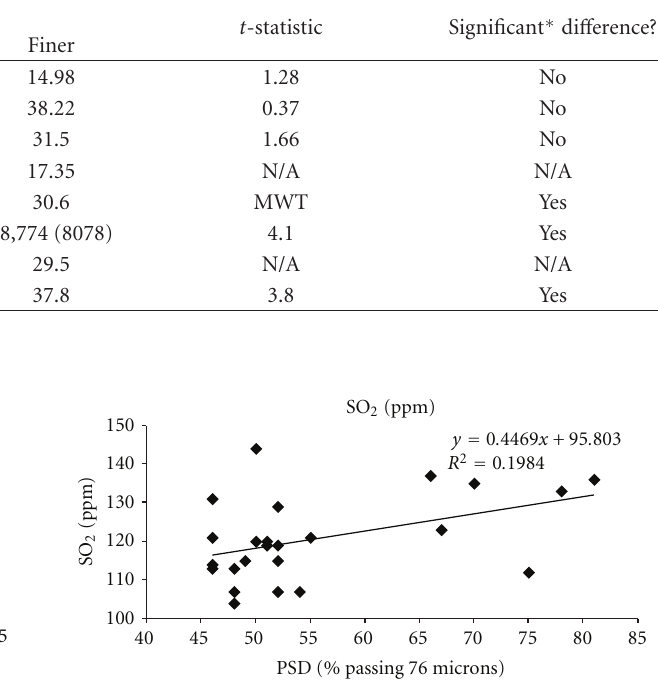
Figure 3: PSD versus CO.